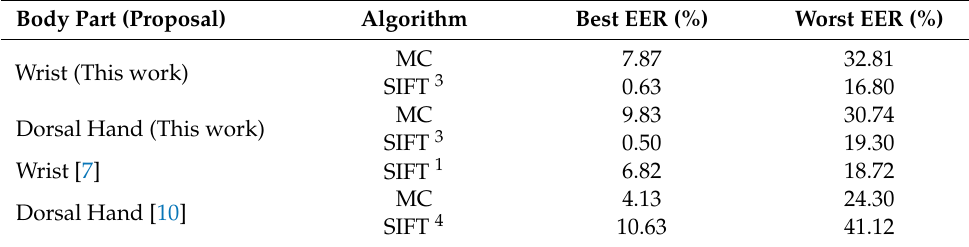
Table 2. Comparison to other proposals in the literature in terms of best and worst EER values. Body Part